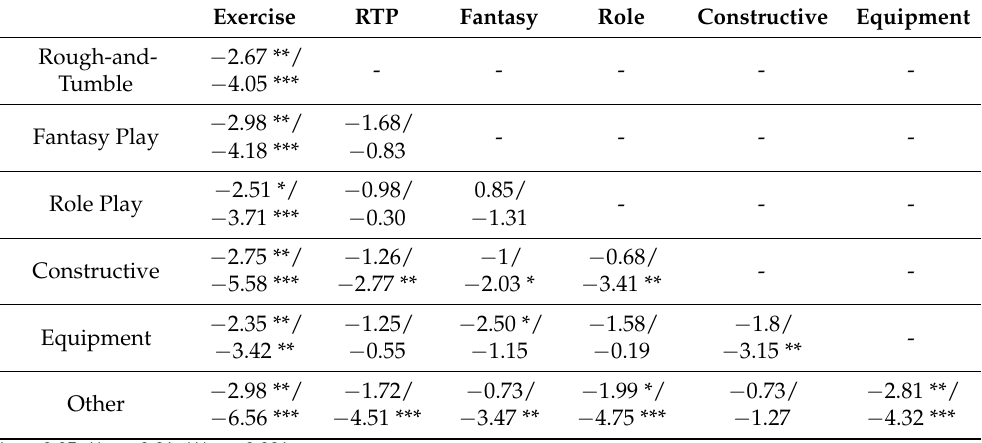
Table 3. Wilcoxon pairwise comparisons regarding types of play of DHH/TH children. Exercise RTP Fantasy Role